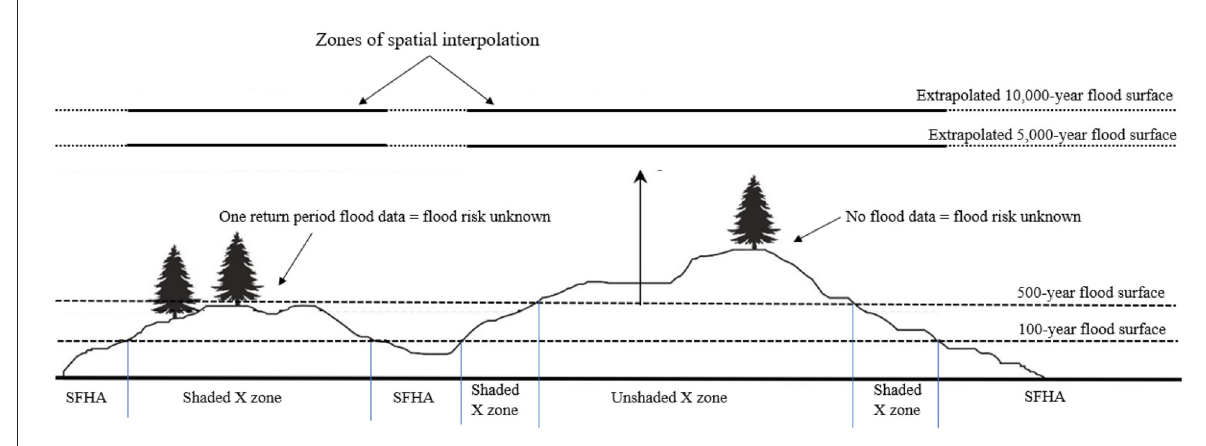
FIGURE1 Schematic representation of the concept behind the flood depth surface estimating method.